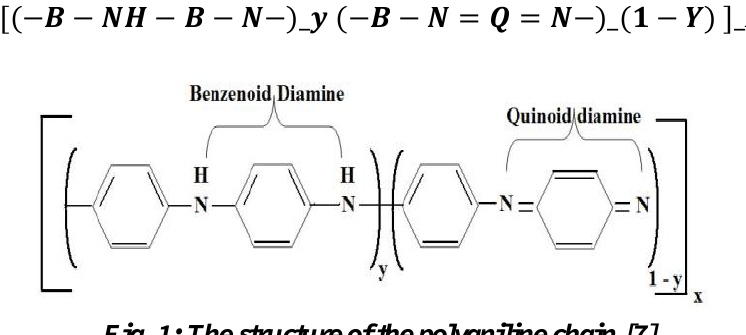
Fig. 1: The structure of the polyaniline chain